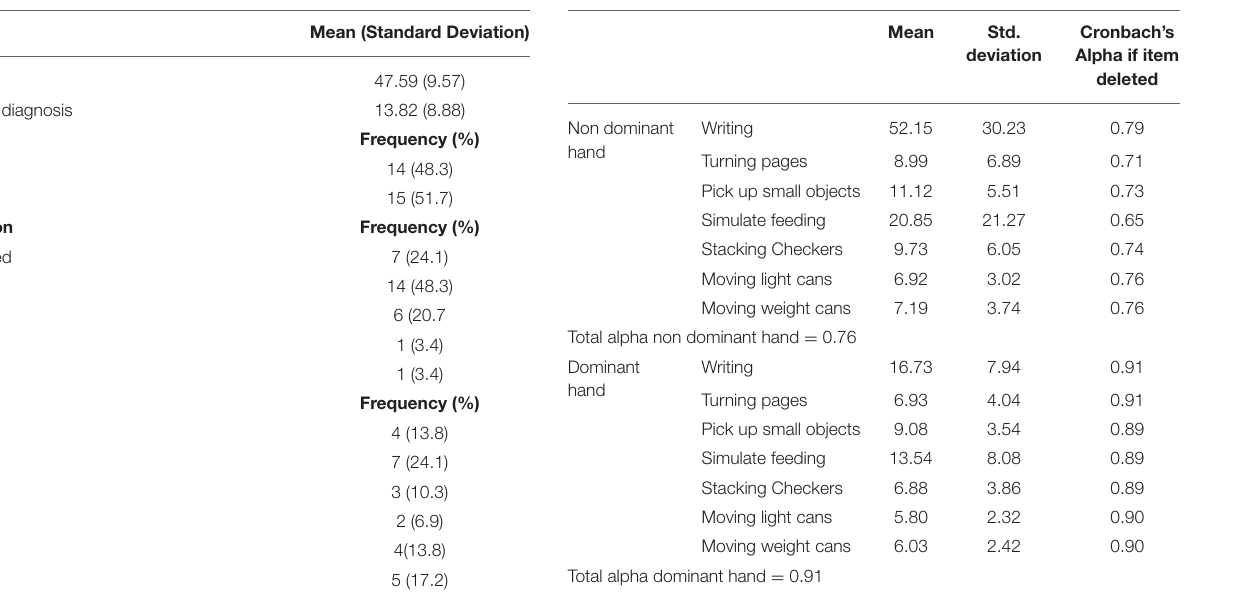
TABLE 1 | Demographic characteristics of the population. TABLE 2 | Mean SD and Cronbach alpha values of one of the items of the